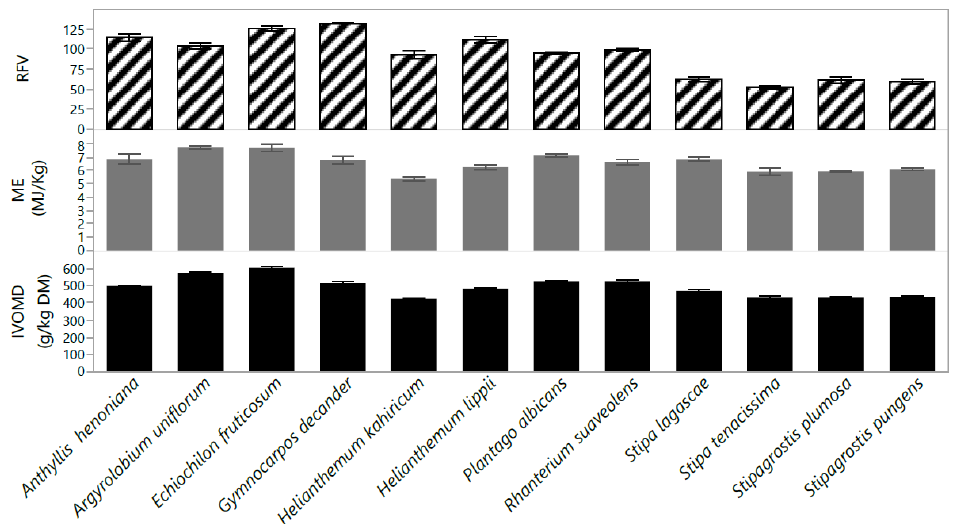
Figure 5. In vitro organic matter digestibility (IVOMD; g/kg DM), metabolizable energy (ME; MJ/kg) and relative feed value (RFV) of twelve native perennial species from arid rangelands of southern Tunisia. Values are the means ± standard error (SE) from 3 replicates (means ± SE). There were positive and significant correlations between the IVOMD and ME (r = +0.82), and REF (r = +0.70) (Figure 6). A high negative and significant correlation was recorded between aNDFom concentration and RFV (r = − 0.95). Crude protein concentrations showed a negative correlation with ADF (r = − 0.82) and aNDFom (r = − 0.78). Crude protein had a strong correlation with RFV (r = +0.79) and acceptability index (r = +0.71) (Figure 6).